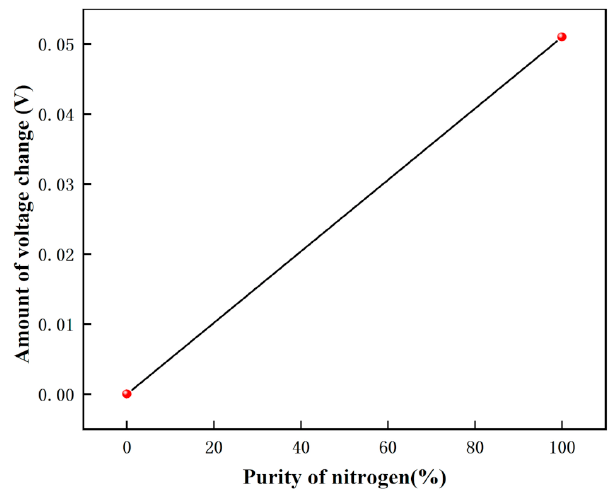
Figure 26. The voltage variation graph for different purity nitrogen